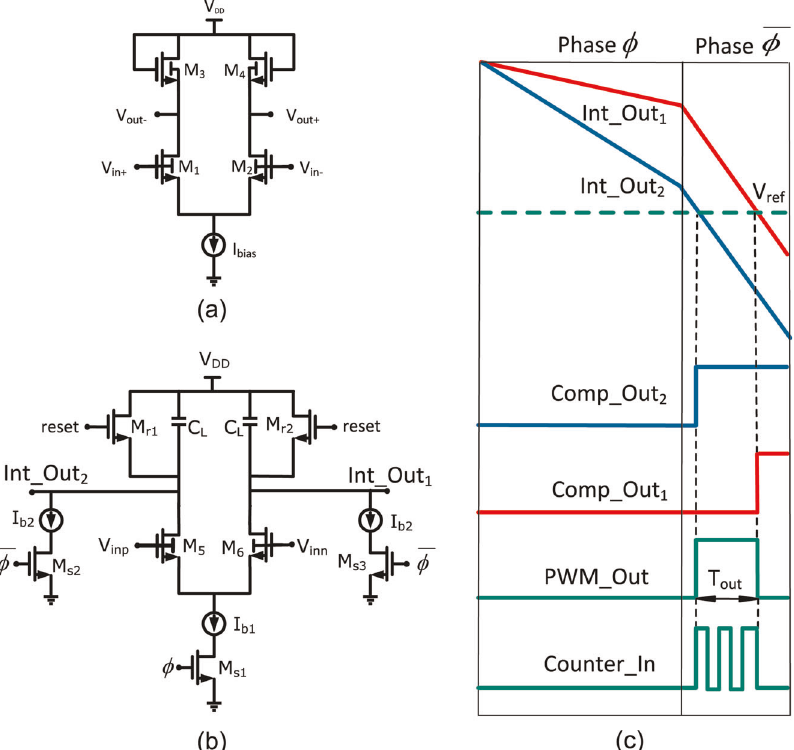
Fig. 3 Circuit schematics and working principle. a Schematics of each of the two cascaded diode-load ampli fi ers in the preampli fi er, b Reset integrator, and c Reset integrator working principle.